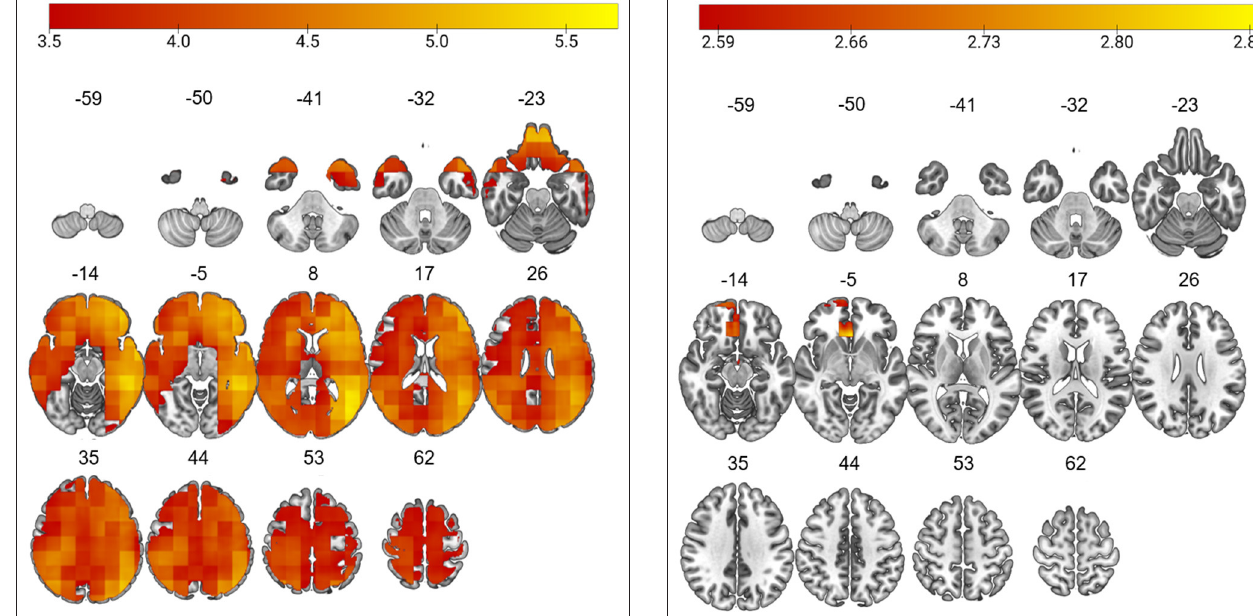
FIGURE 3 | Differences in L-brainAGE between healthy individuals and the cognitively spared patient subgroup. T -value overlay of statistically significant group differences in L-brainAGE based on a two-sample t -test comparing healthy individuals with the cognitive spared patients (P uncorrected < 0.005). The color bar shows regions in which patients with spared cognition have higher brainAGE compared to healthy individuals. Images are displayed in neurological orientation with MNI